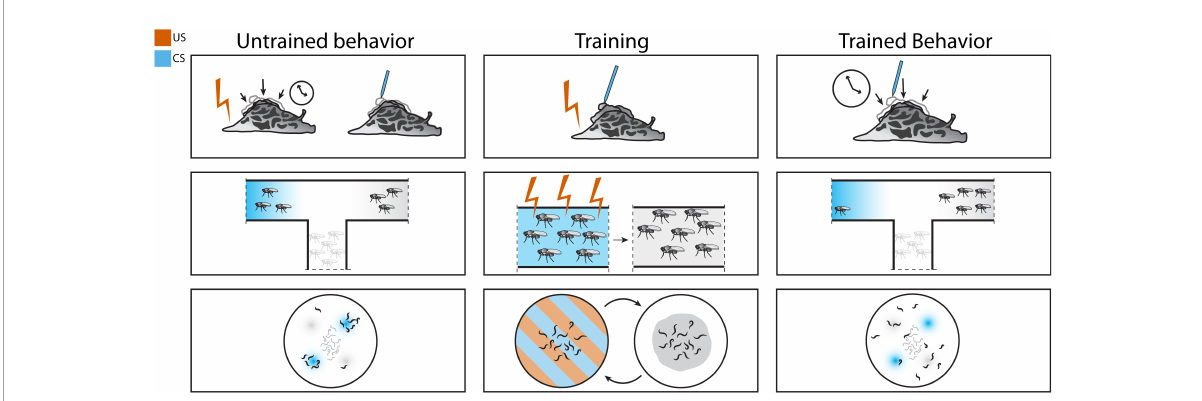
FIGURE1 Associative conditioning schemes in Aplysia (top) , Drosophila (middle) , and Caenorhabditis elegans (bottom) . Classical conditioning in Aplysia : training is performed by pairing electric shock with siphon touch. After training, siphon touch elicits the longer whole-body withdrawal response normally seen only with electric shock. Olfactory fear conditioning in Drosophila melanogaster : pairing electric shock with odor can alter olfactory preference. Aversive olfactory conditioning in C. elegans : pairing acid with odor results in avoidance of the paired